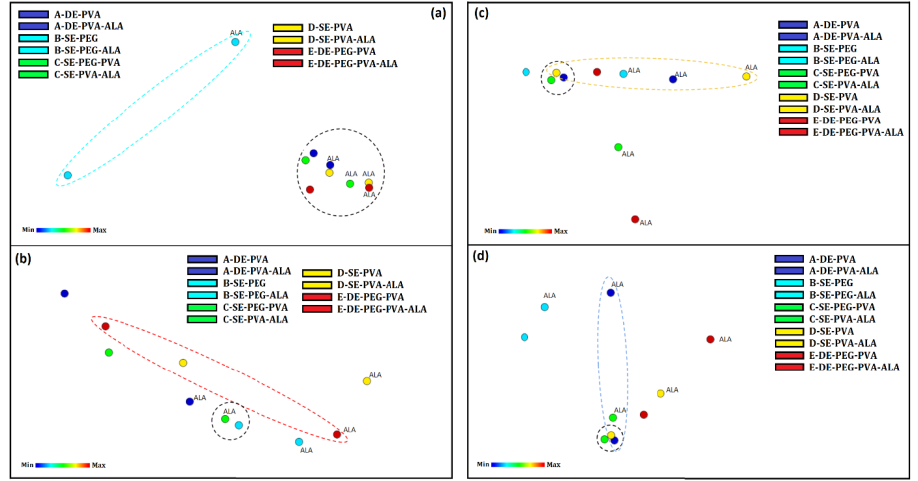
Figure 8. ( a ) IDMAP maps for zeta potential analysis; ( b ) IDMAP maps for pH analysis; ( c ) IDMAP maps for the particle size and ( d ) IDMAP maps for the PDI of System A (A – DE – PVA and